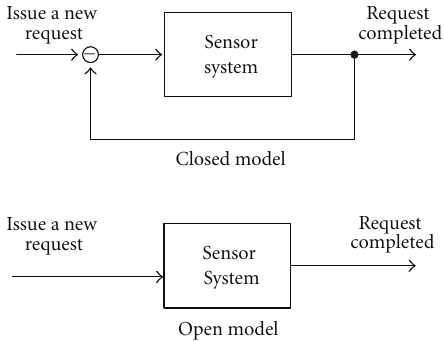
Figure 2: Closed workload generator model and open workload generator model.